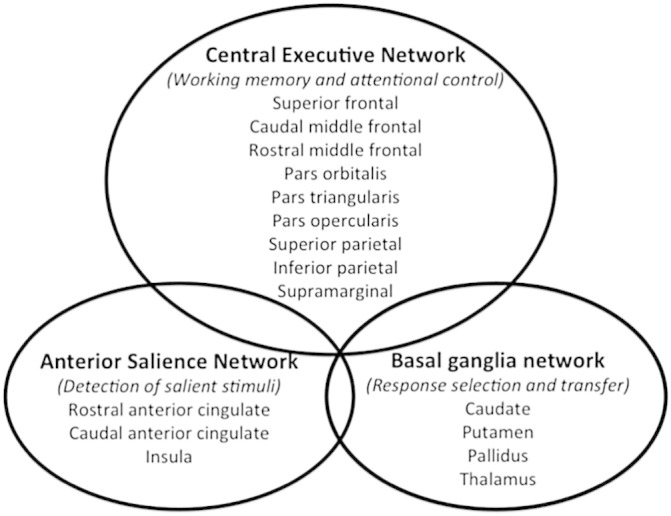
Schematic representation of cortical and sub-cortical regions of cognitive control networks and their proposed function. Target regions of the central executive, anterior salience and basal ganglia networks were selected from the Desikan–Killiany atlas (Desikan et al., 2006). Executive parieto-frontal regions selected were the inferior parietal cortex, superior parietal cortex, supramarginal gyrus encompassing intraparietal sulcus, caudal middle frontal gyrus, rostral middle frontal gyrus, superior frontal cortex as well as pars opercularis, pars triangularis, and pars orbitalis of the inferior ventro-lateral prefrontal cortex. Anterior salience network regions selected were the insula and caudal and rostral anterior cingulate cortices. Sub-cortical regions of the basal ganglia, i.e., caudate, putamen, and globus pallidum and the thalamus were also included in the analyses. All regions were included from both hemispheres.